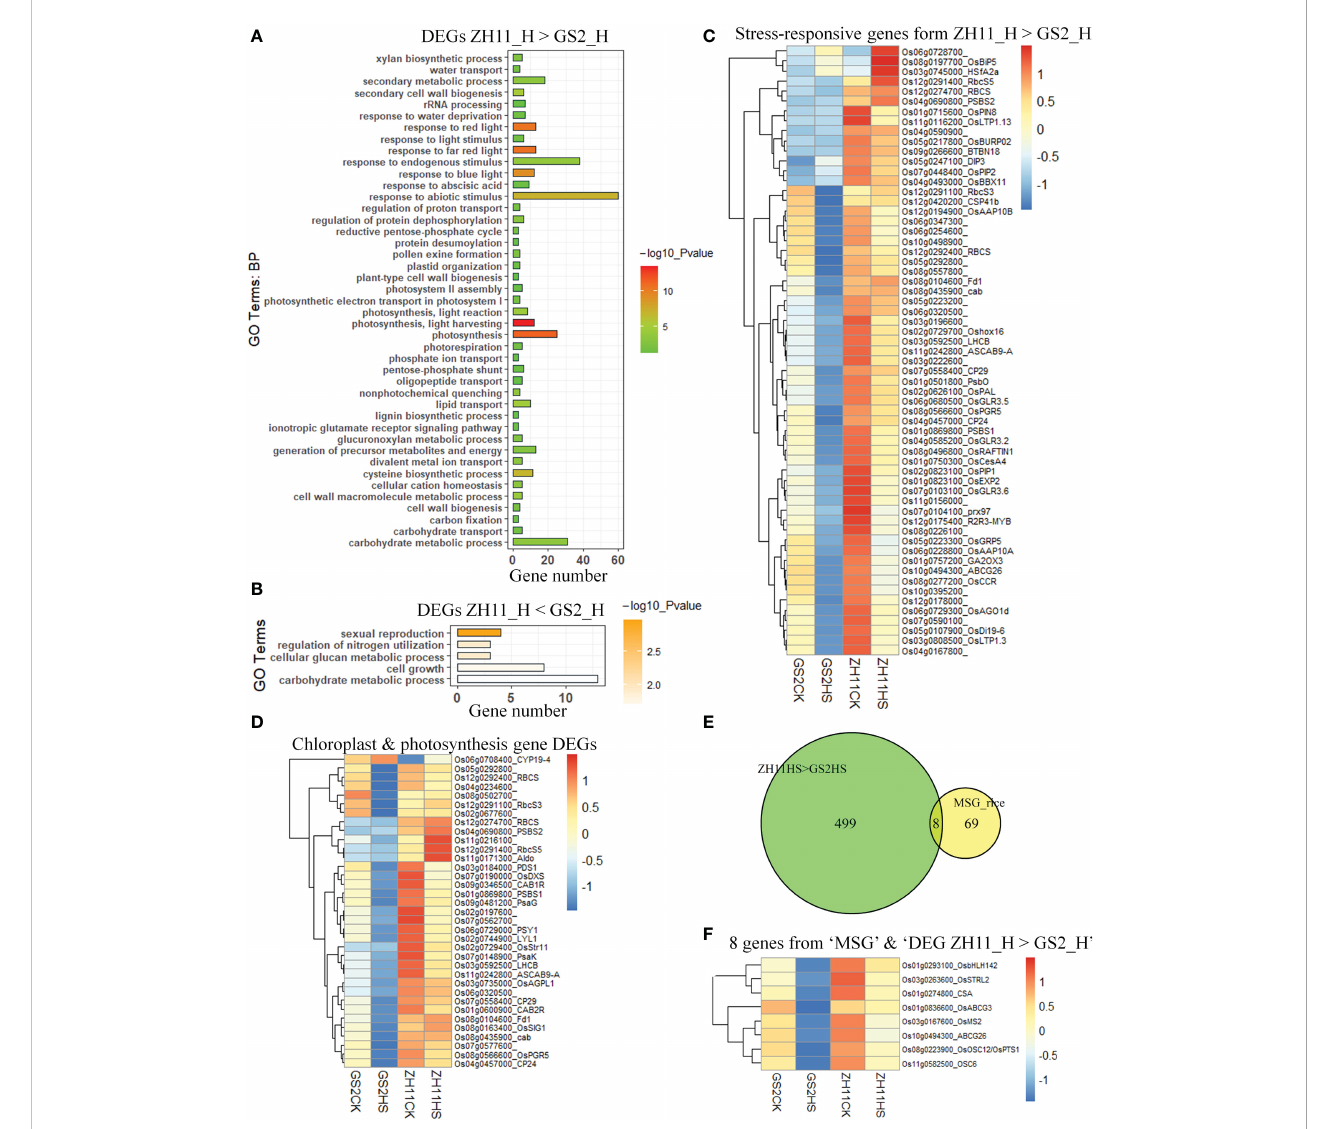
FIGURE 5 Differentially expressed genes (DEGs) essential for male fertility in anthers from Zhonghua 11 (ZH11) and grain size on chromosome 2 (GS2) after heat stress (HS) treatment. (A) Gene ontology (GO) analysis of DEGs with higher levels of expression in ZH11. (B) GO analysis of DEGs with lower levels of expression in ZH11. (C) Expression patterns of 60 stress-responsive DEGs with higher levels of expression levels ZH11. (D) Expression patterns of those DEGs involved in chloroplast development and photosynthesis. (E) The overlap of male sterile genes (MSGs) and those expressed at a higher level in ZH11 than in GS2. (F) Gene identi fi ers (IDs) and relative expression patterns of the eight MSGs in